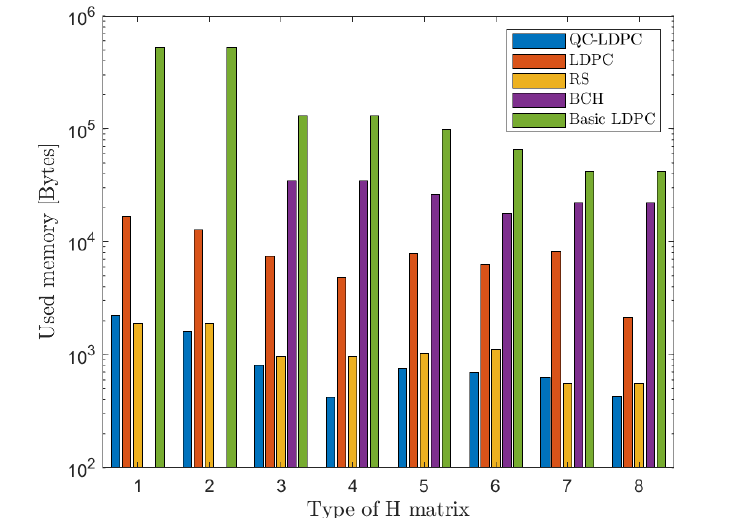
Figure 6. Memory utilization of the implemented encoders.